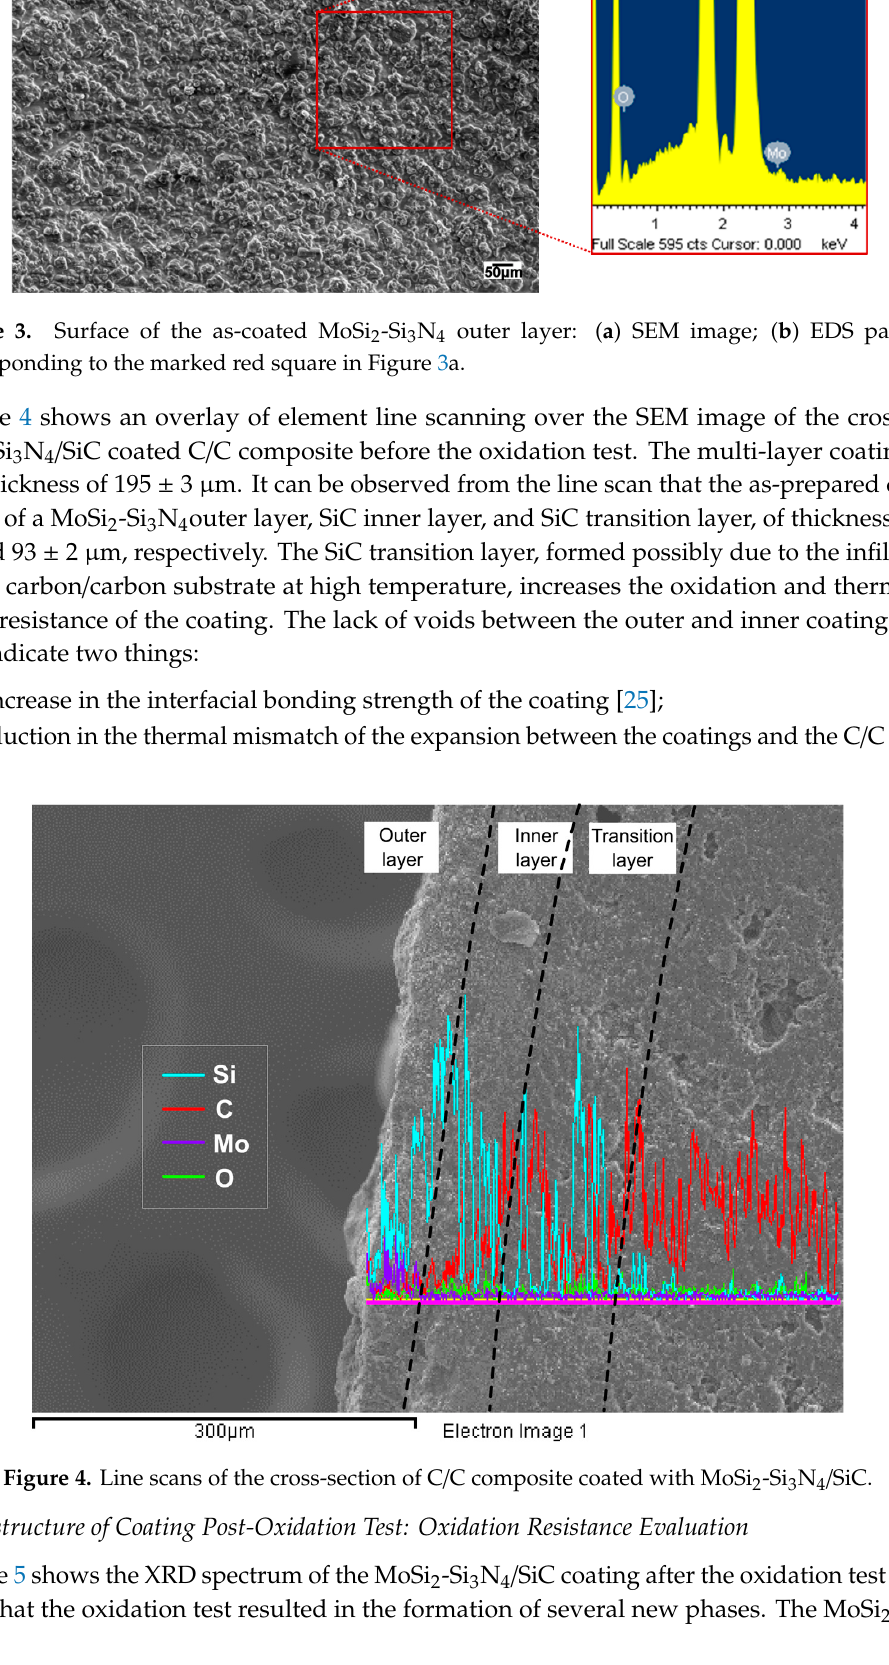
Figure 4. Line scans of the cross-section of C/C composite coated with MoSi 2 -Si 3 N 4 /SiC.